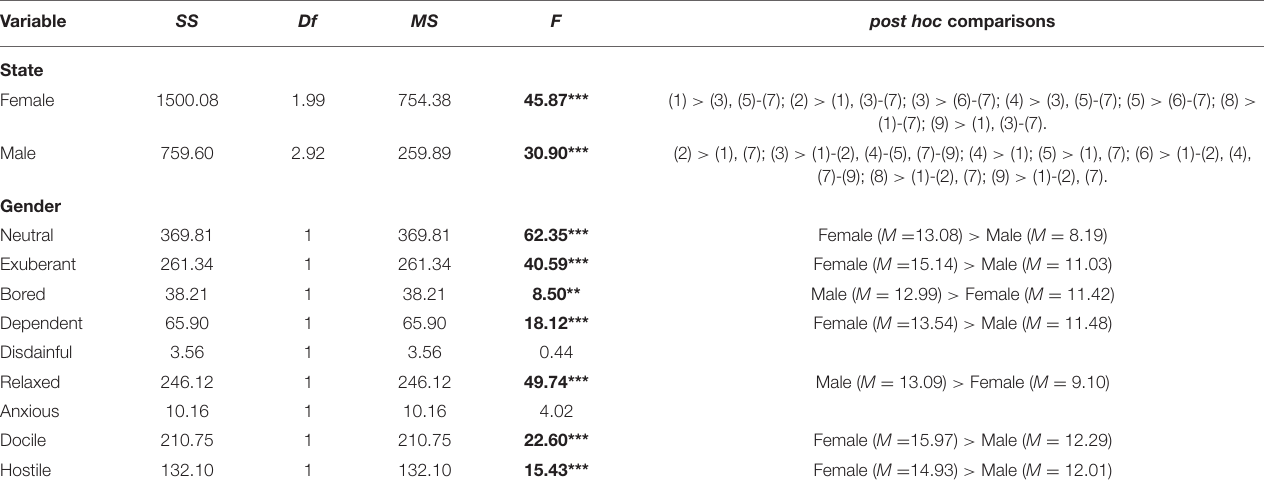
TABLE 10 | Simple main effect test of mixed design of gender and emotional states in HNR. Variable SS Df MS F post hoc